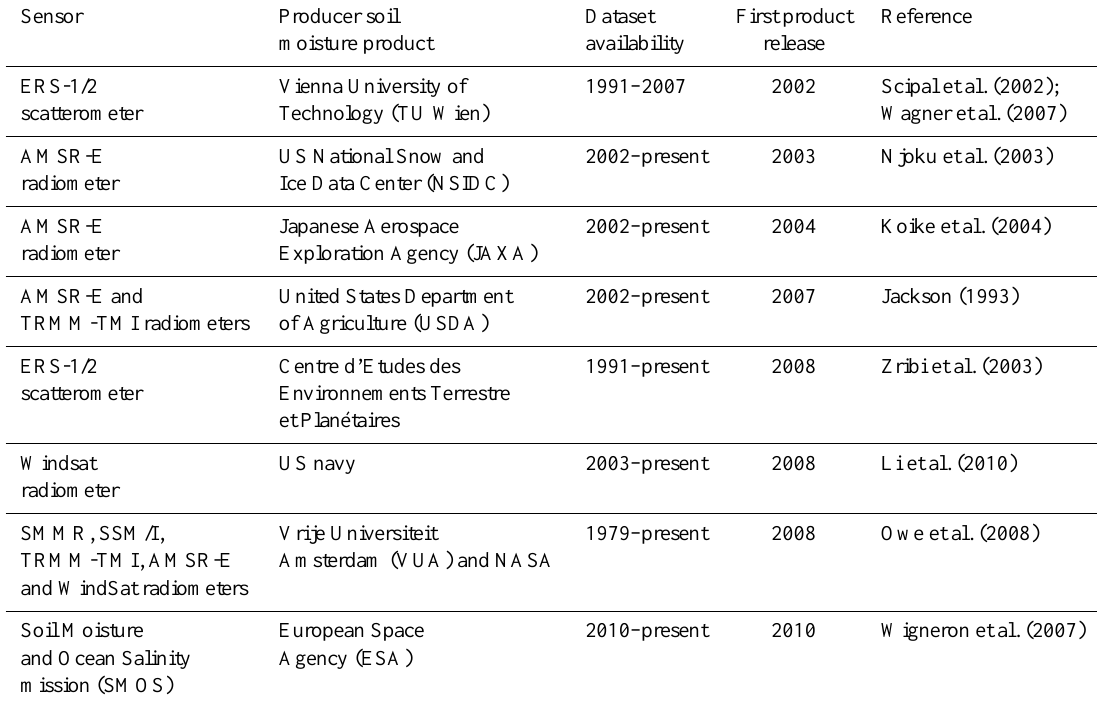
Table 1. Operational products in the field of global monitoring of soil moisture using active and passive satellite microwave instruments (sorted according to product release